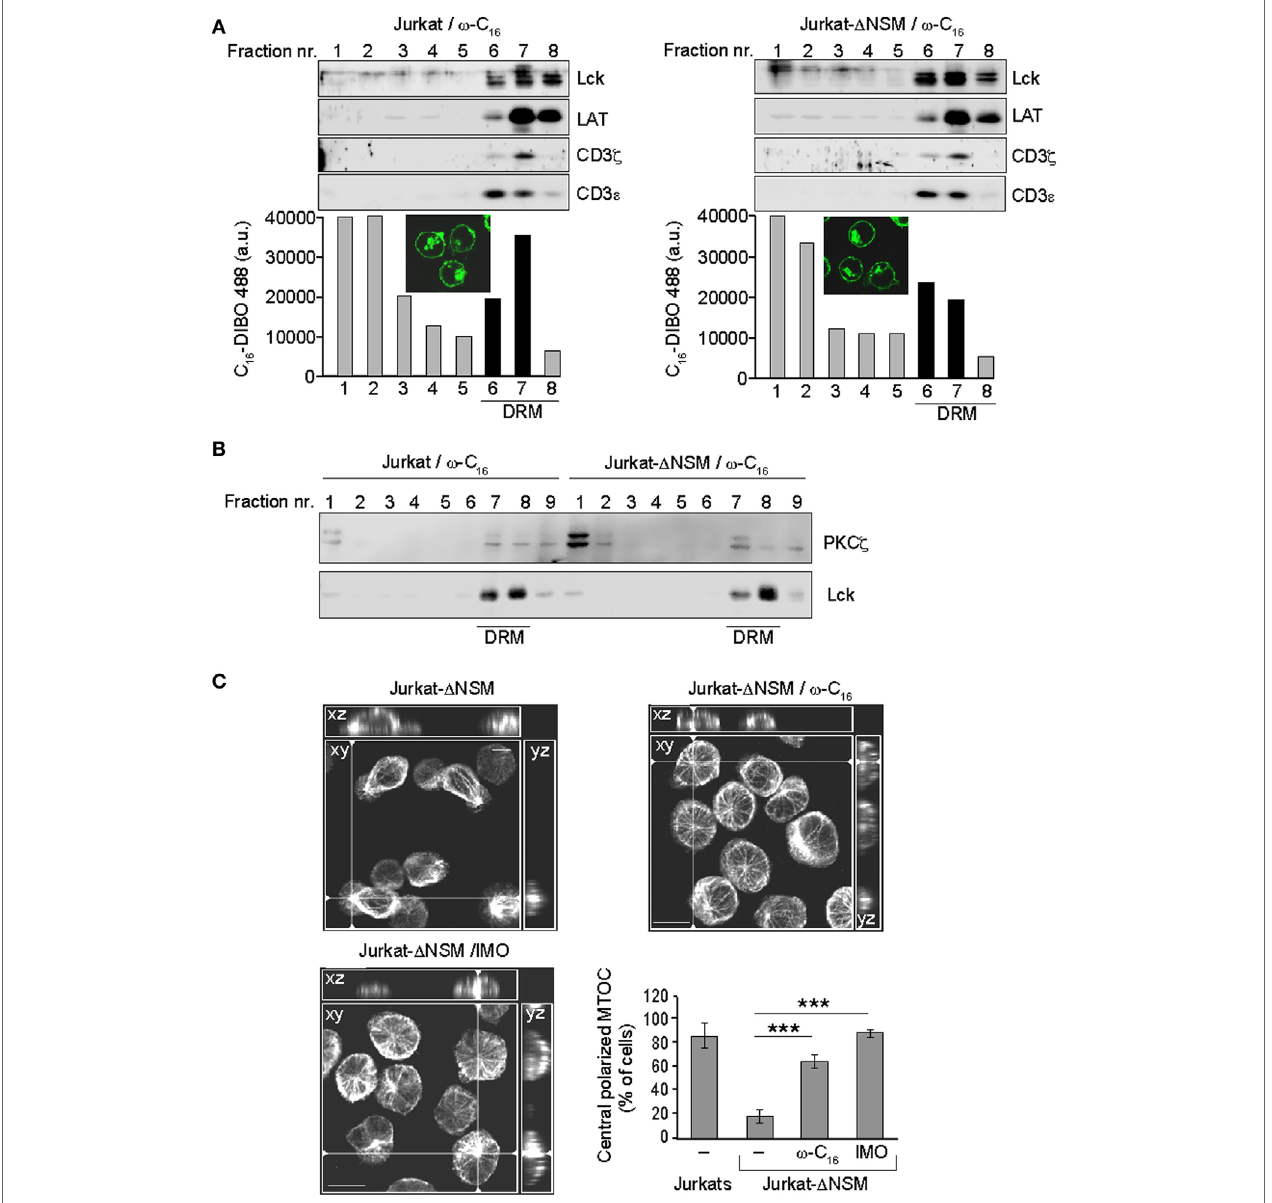
FigUre 7 | Ceramide supplementation rescues PKC ζ detergent resistant membrane (DRM) association and microtubule-organizing center (MTOC) polarization in α -CD3-stimulated NSM-depleted T cells. (a) Parental and Jurkat- Δ NSM cells were loaded with functionalized ω -C16-ceramide, DIBO488-clicked and analyzed by IF [ (a) insets] and subjected to floatation gradient centrifugation after which fractions containing DRM resident proteins Lck, LAT, CD3 ζ , and CD3 ε (serving as DRM markers) were identified by Western blot (upper panels) and accumulation of DIBO488 was measured in all fractions by fluorescence reader (bottom panels). (B) DRM domain association of PKC ζ was determined after 5 min of α -CD3-stimulation of parental and Jurkat- Δ NSM cells pre-loaded with ω -C 16 -ceramide (detection of Lck was used to identify DRM fractions). (c) Jurkat- Δ NSM loaded with ω -C 16 -cermide or pretreated with the GSK3-inhibitor indirubin-3 ′ -monoxime were α -CD3 stimulated. Graph shows the percentage of MTOC polarizing cells quantified after 15 min of stimulation as described in Figures 6B,c . Representative IF pictures for each condition are shown. Size bar: 10 µM. (a–c) One representative experiment out of three is